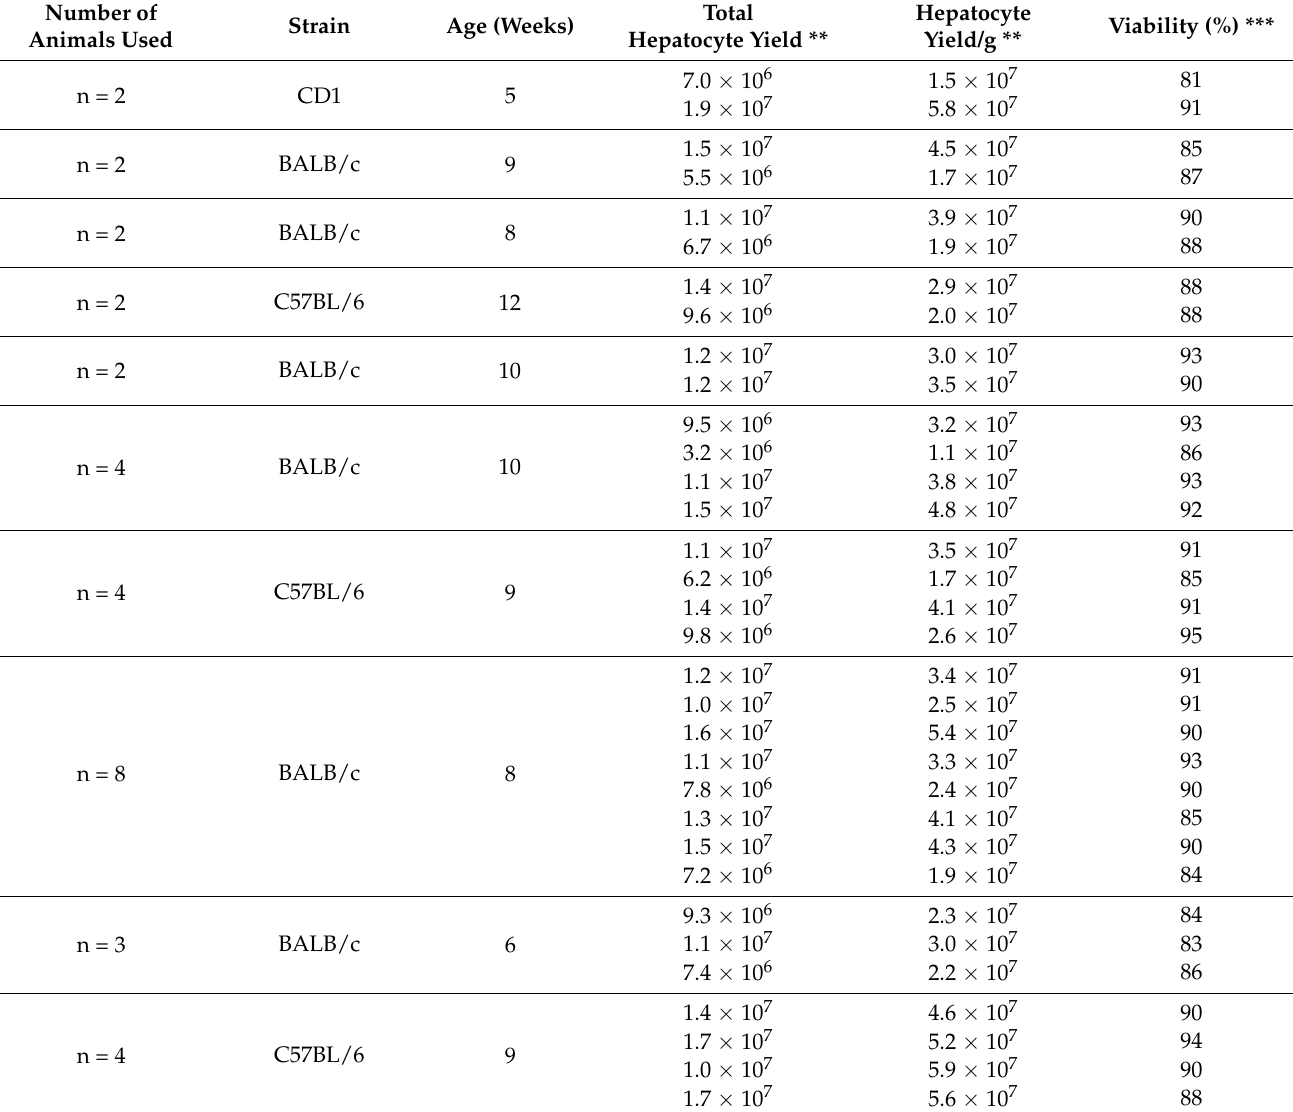
Table 1. Representative hepatocyte isolations from female mice (n = 33)